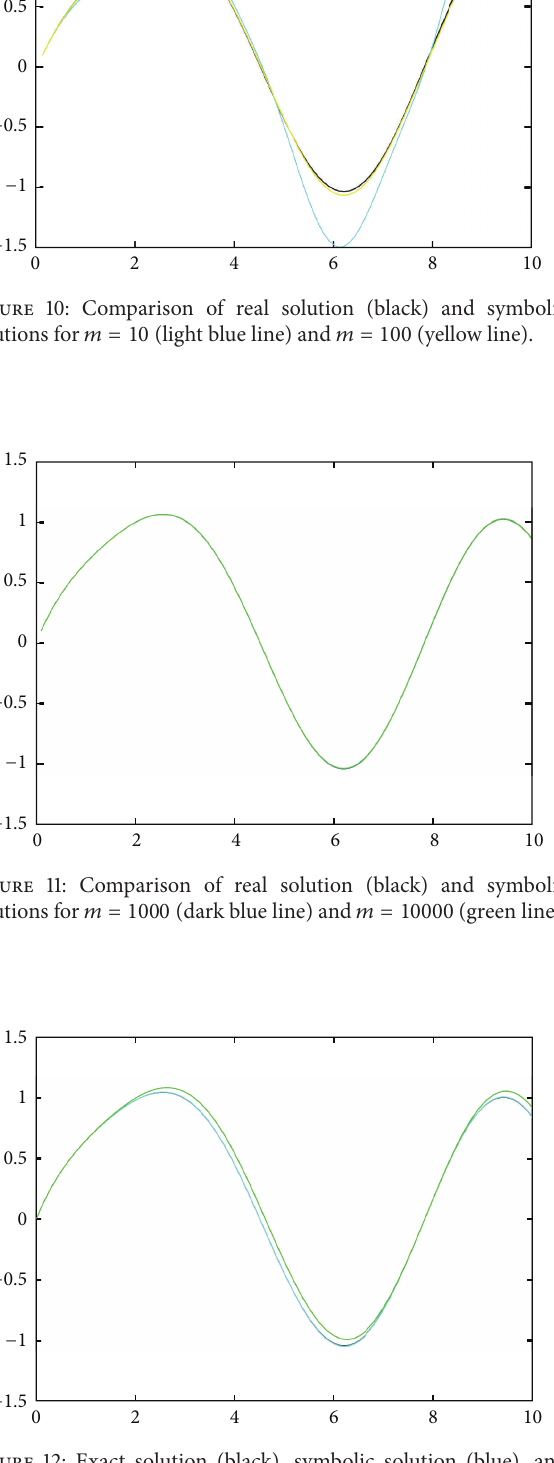
Figure 12: Exact solution (black), symbolic solution (blue), and numeric solution (green).